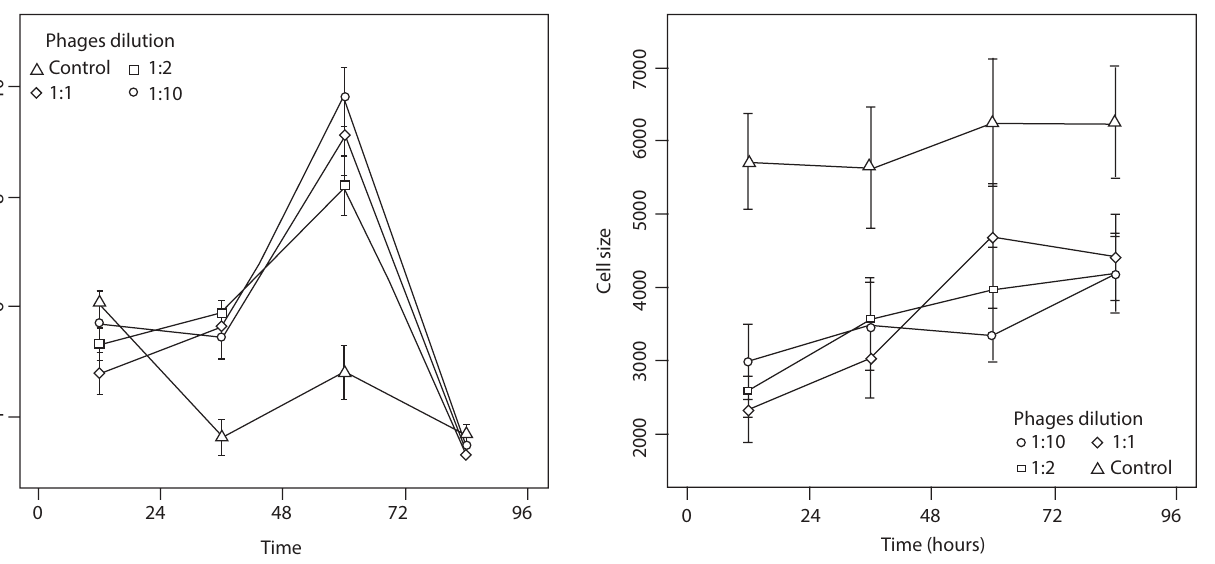
Figure 2. Mean bacterial cell size (forward scatter parameter) exposed to different concentrations of UV-inactivated phage, as per the method in Figure 1. Bacteria exposed to phage at different concentrations do not significantly differ in size. Points and bars are the same as in Figure